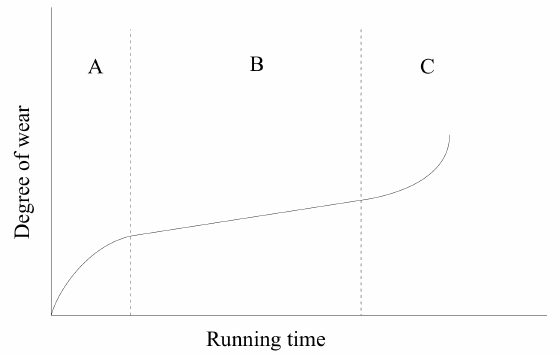
Figure 1. Bearing wear states curve through the whole